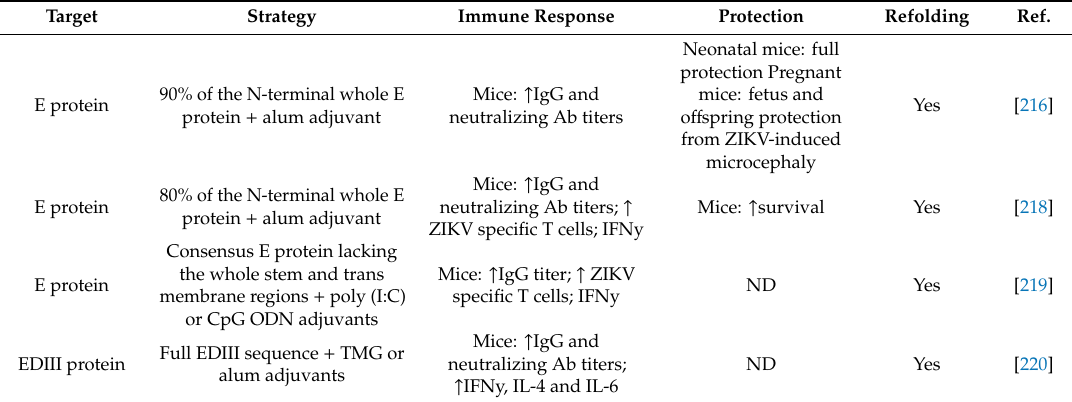
Table 6. Strategies for ZIKV subunit vaccines produced in E. coli for preclinical evaluation.